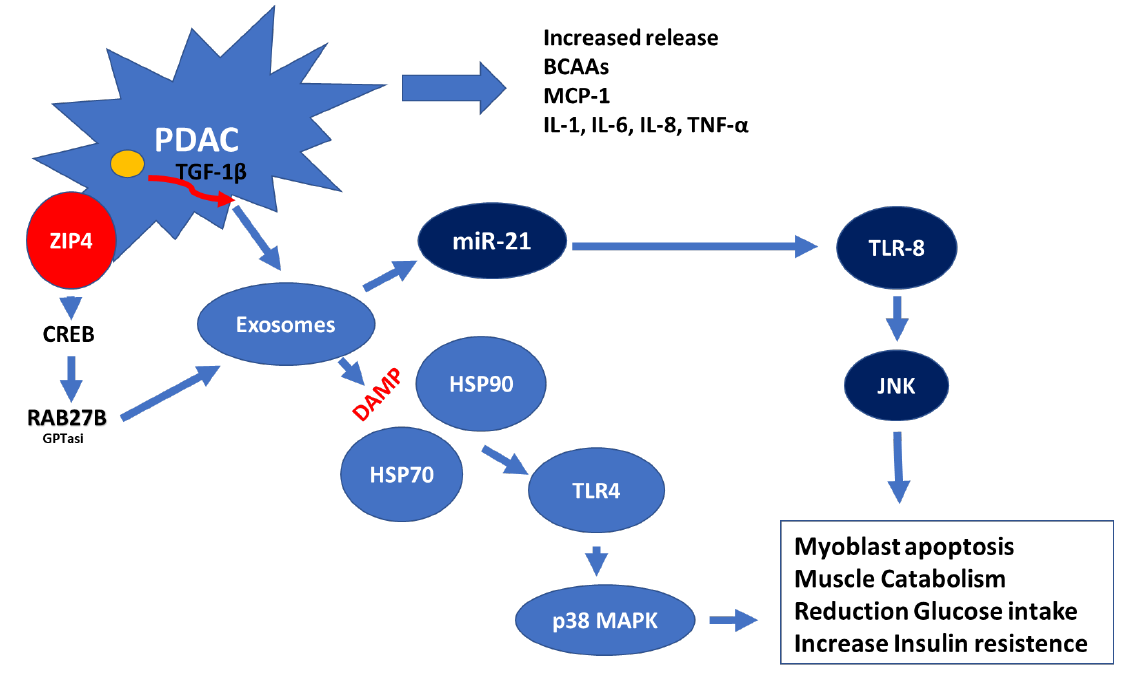
Figure 3. Pancreatic ductal adenocarcinoma pathophysiology pathway in the sarcopenia development. In pancreatic cancer extracellular vehicles are released under the influence of ZIP4 through zinc-sensitive transcription factor CREB followed by the up-regulation of RAB27B. HSP70- and HSP90-positive EVs are examples of the released damage-related molecular patterns released by pancreatic cancer cells. These DAMPs activate TLR4 in skeletal muscle tissues leading to p38 MAPK-mediated muscle protein degradation activation. Simultaneously, the release miRNA-21 containing EVs induces myoblast apoptosis via toll-like receptor 8 (TLR8) activation through the c-Jun N-terminal kinase (JNK)